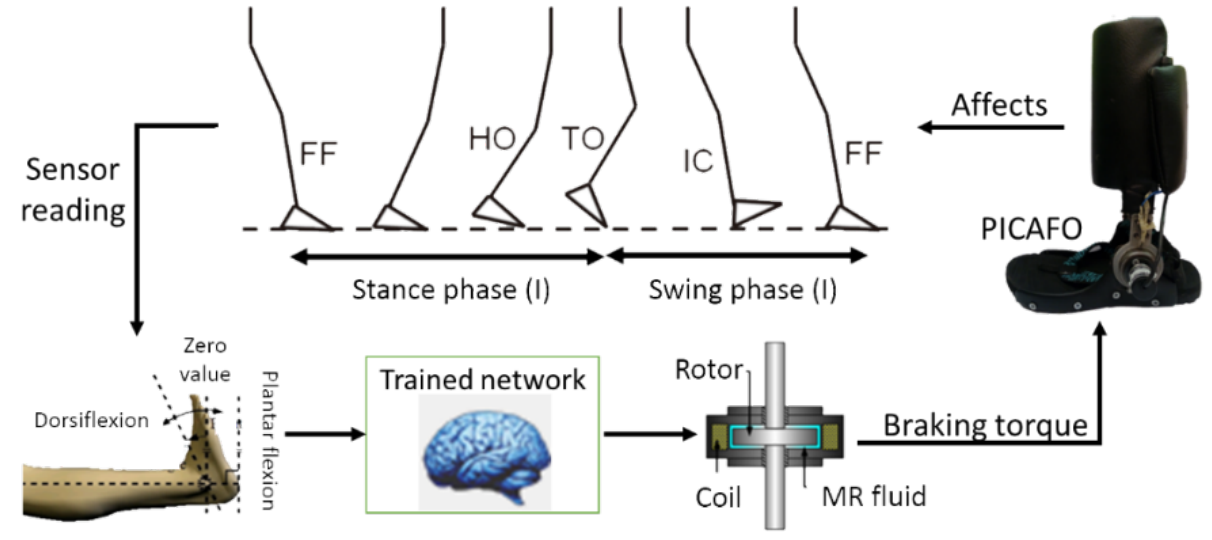
Figure 9: Improved PICAFO control